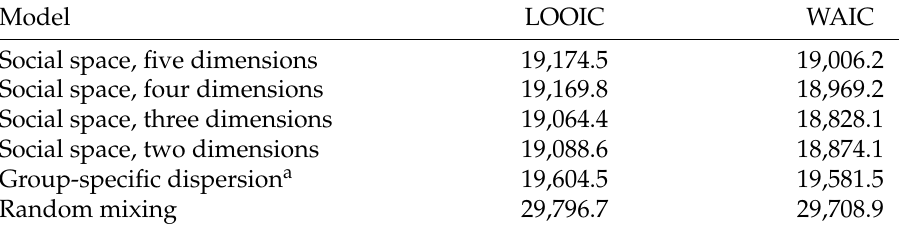
Table 2: Model comparison based on leave-one-out cross validation using Pareto- smoothed importance sampling and Watanabe–Akaike information